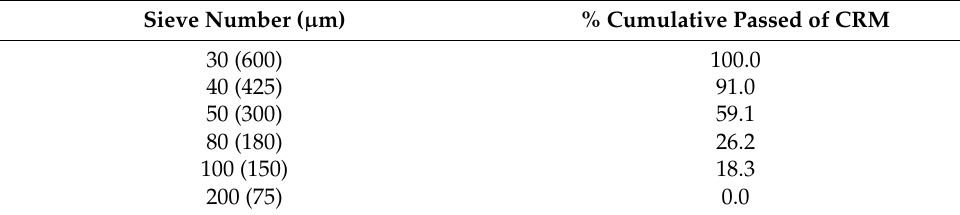
Table 2. Gradation of crumb rubber used in this study.